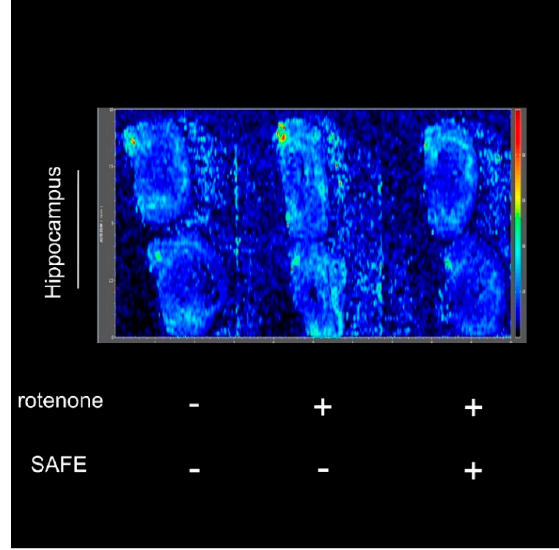
Figure 6. Imaging mass spectrometry analysis. After 10 days of rotenone treatment, increased Ach was detected in the hippocampus. After 24 days of low-dose SAFE (35 g/kg/day) treatment, the Ach levels were clearly decreased. Data are representative of three independent experiments with similar results ( n = 3).